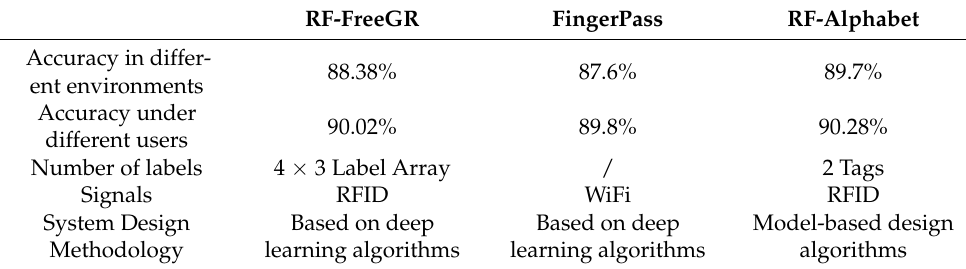
Table 2. Comparison with the latest